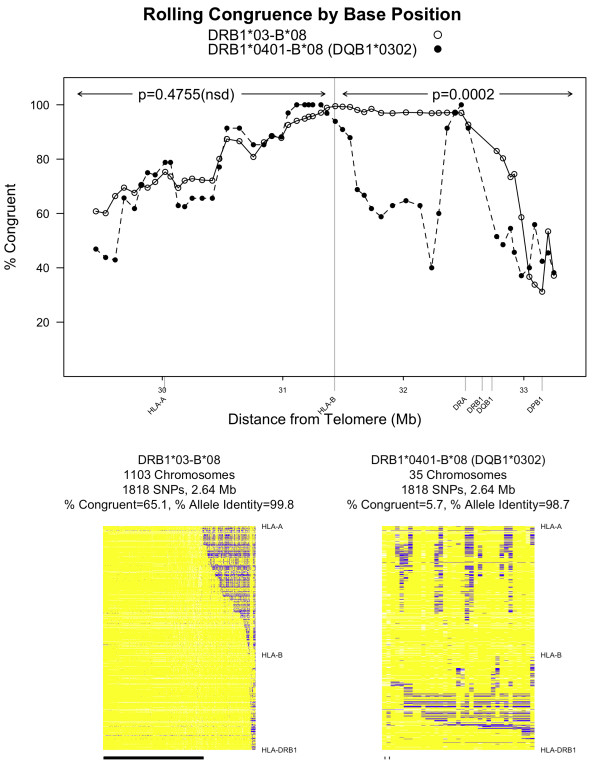
Comparison of two haplotype groups from the T1DGC. A: Congruence was calculated separately for two haplotype groups, DRB1*03-B*08 and DRB1*0401-B*08 (DQB1*0302). There is a significant difference in the congruence between the two groups centromeric of HLA-B, while the congruence within the two groups is not significantly different telomeric of HLA-B. B: In these two images, each column illustrates one founder chromosome (represented by 1,818 SNPs across 2.64 Mb ranging from HLA-DRB1 to HLA-A on chromosome 6) with the specified HLA alleles (e.g., DRB1*03 and B*08). Each row illustrates data for one SNP. Yellow represents alleles that match the consensus sequence, whereas blue represents alleles that do not match the consensus. White denotes missing or unphased alleles. Congruent chromosomes are indicated by a tick mark at the bottom of the image. The DRB1*03-B*08 chromosomes are highly congruent across the entire region from HLA-DRB1 to HLA-B, and in many cases from HLA-DRB1 to HLA-A. On the other hand, the DRB1*04-B*08 (DQB1*0302) chromosomes are congruent around HLA-B but are not congruent near HLA-DRB1 or HLA-A